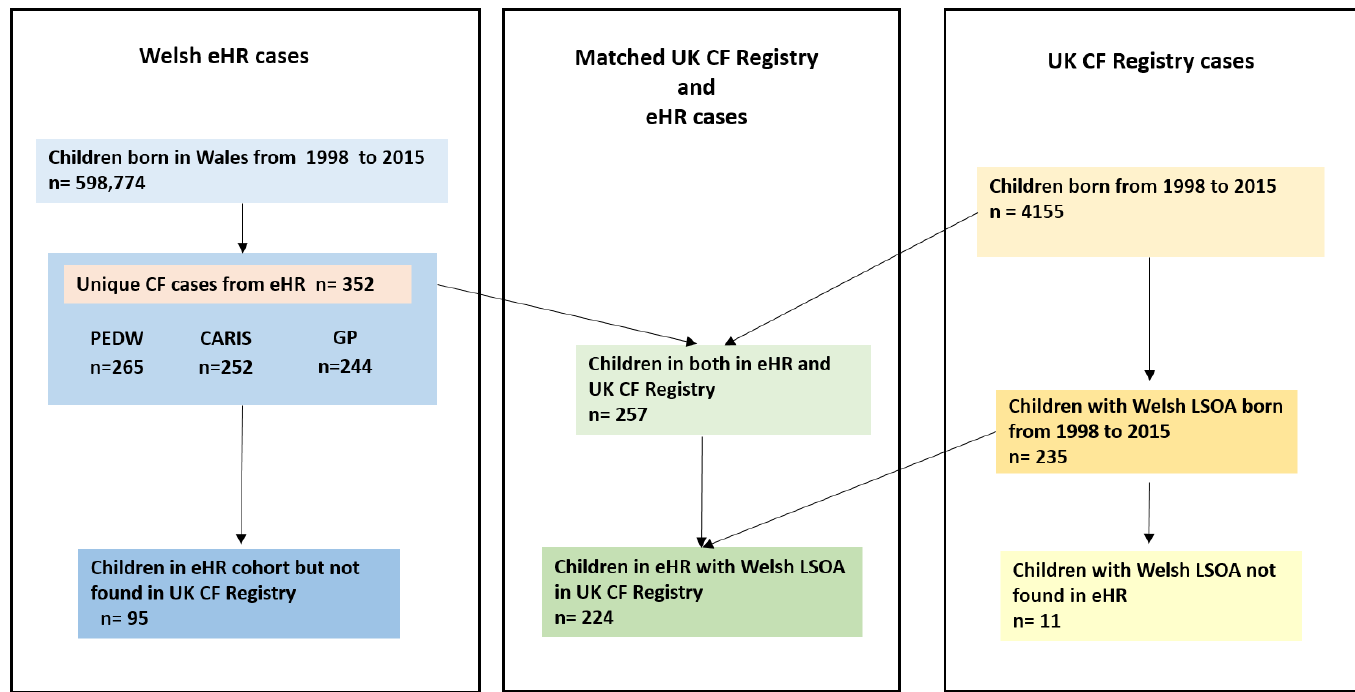
Figure 1: Illustration of the number of children with cystic fibrosis (CF) identified in electronic health records (EHR) in Wales, the number children in the UK CF Registry and the number of cases matched between the EHR cohort and the Registry. Sources used for identification of CF cases in EHR were Patient Episode Database for Wales (PEDW), Congenital Anomaly Register Information Service (CARIS) and Welsh Longitudinal General Practice